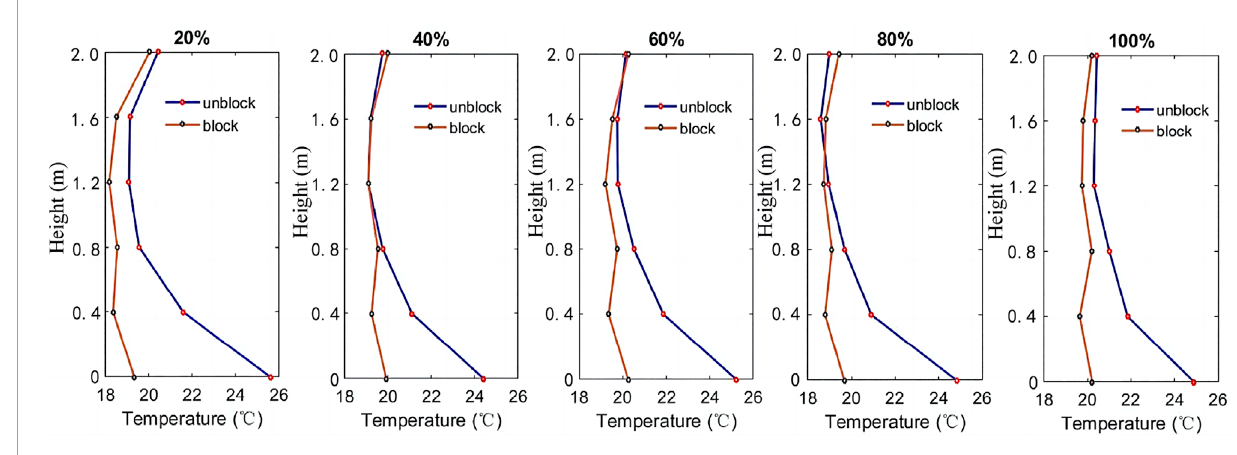
FIGURE 10 Comparison of rack inlet temperature for blocked and unblocked under-rack gaps.